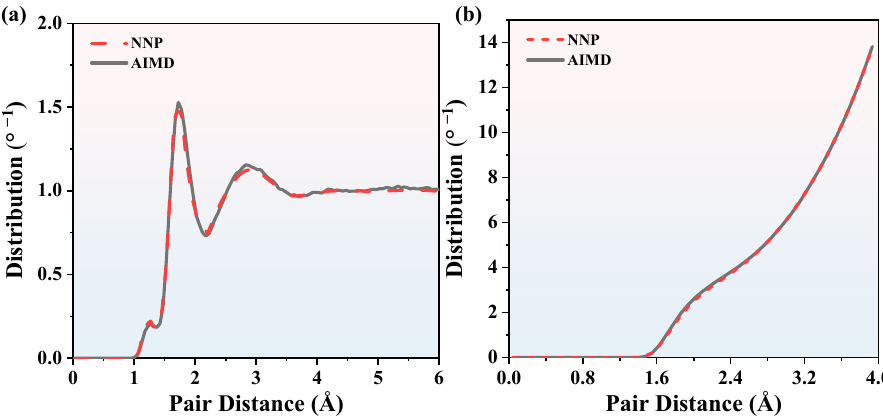
Figure 4. The comparisons of ( a ) Si 3 N 4 RDFs between NNP + MD and AIMD calculations and ( b ) Si 3 N 4 CNs between NNP + MD and AIMD calculations. The temperature is 3000 K. CNs are the number of coordination atoms around the central atom of a